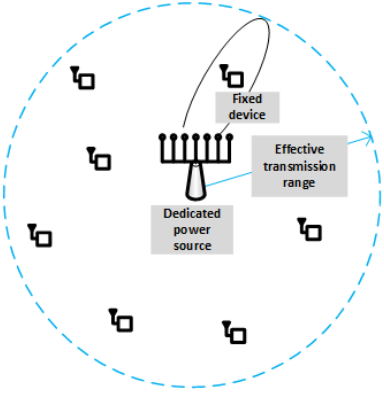
Figure 4. System